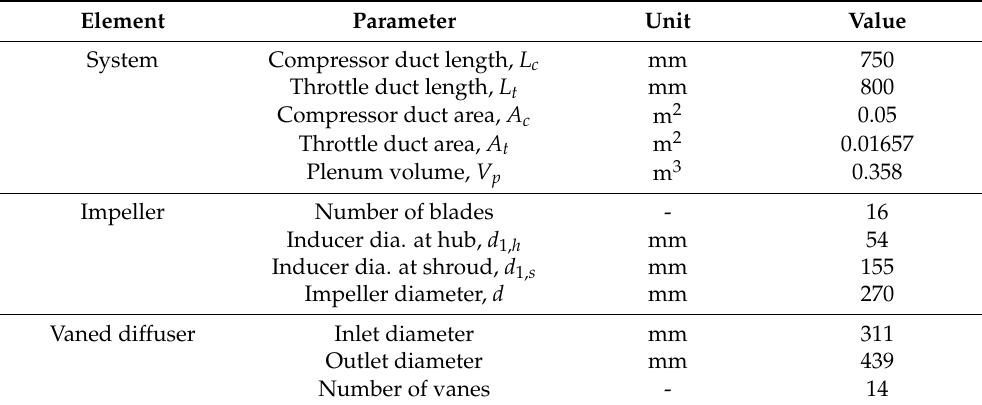
Table 1. Geometrical parameters of the compression system and